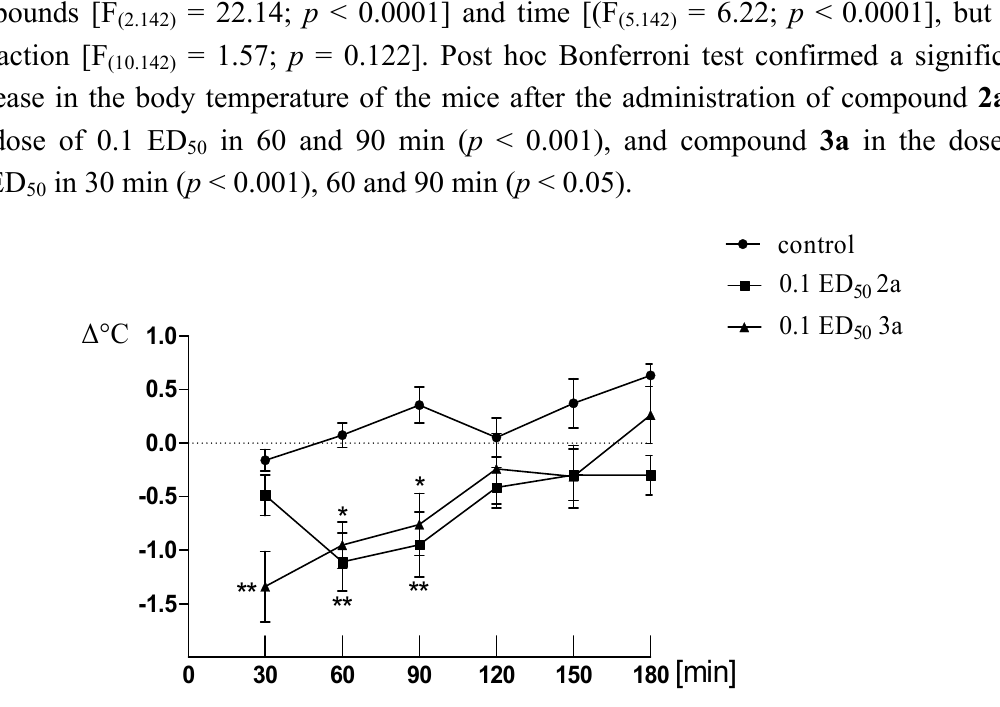
) on the body 50 = 6.22; p < 0.0001], but not (5.142)